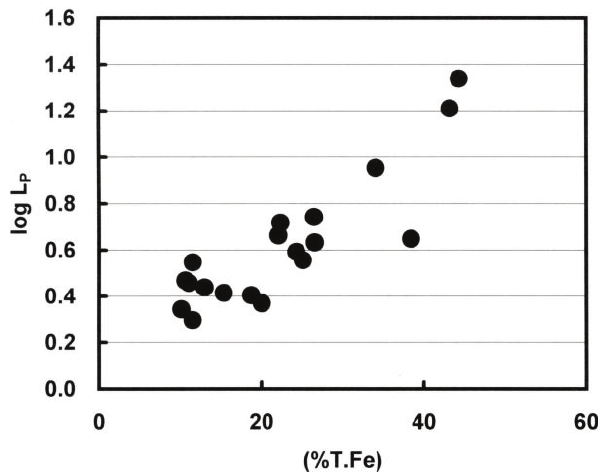
Figure 1. Relation between distribution ratio and T.Fe con- tent in liquid phase [2].